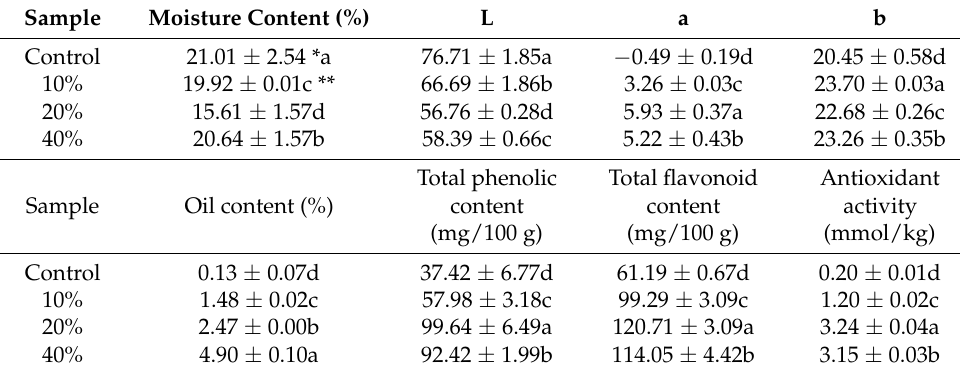
Table 1. Some chemical and bioactive properties of bread samples enriched with chufa flour at different concentrations